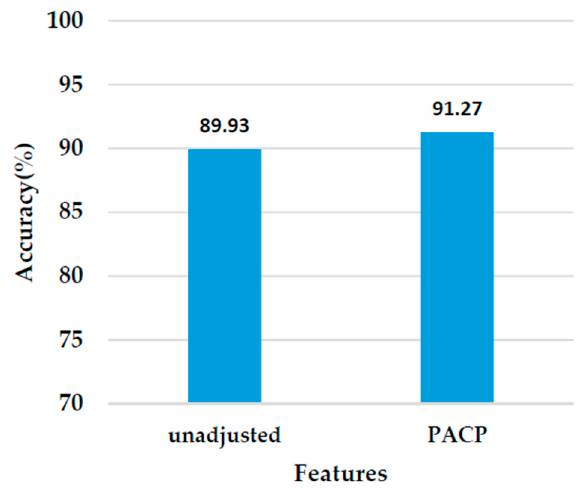
100 Table 6. Accuracy of different positions. Position